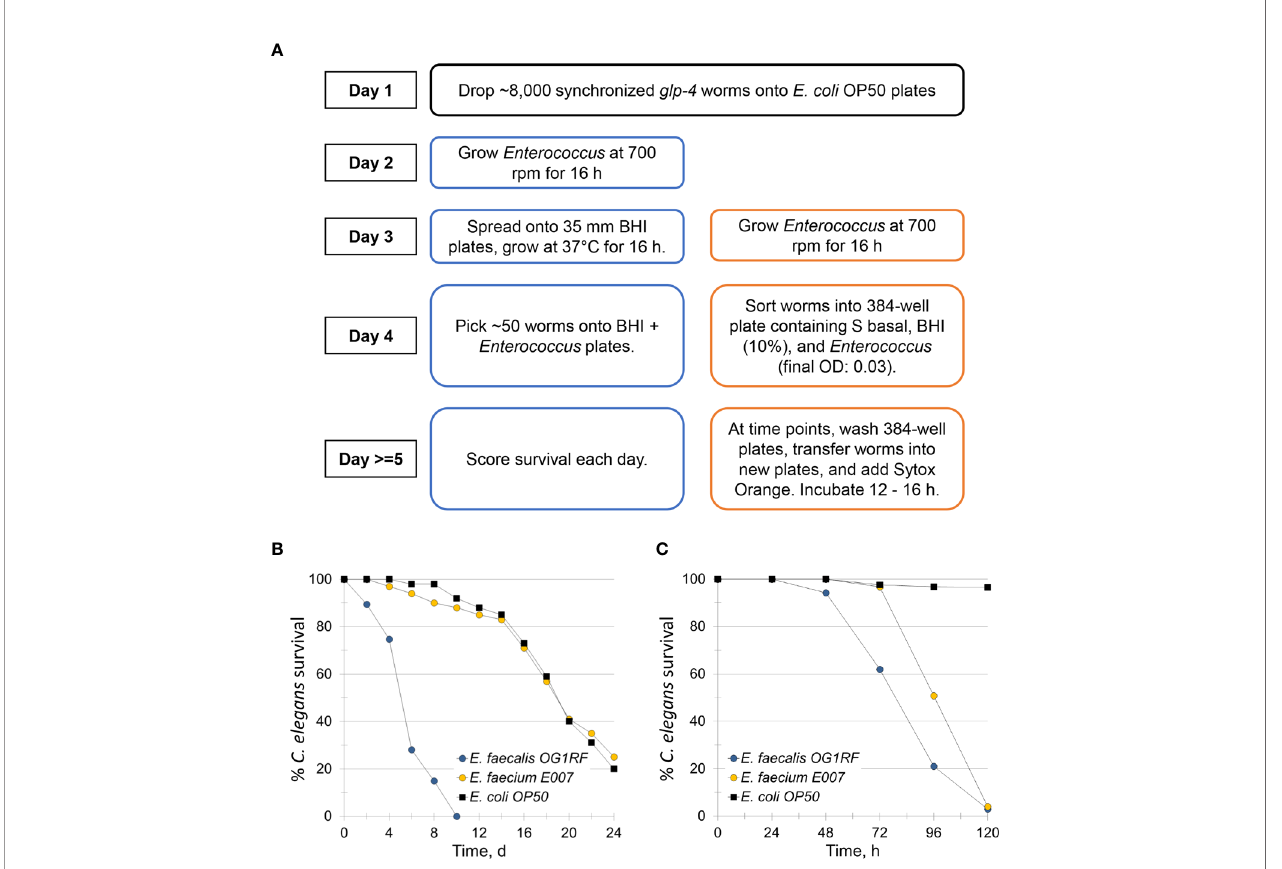
FIGURE 1 | E. faecium E007 is pathogenic to C. elegans in the Enterococcus liquid-killing assay. (A) High-throughput, liquid-based C. elegans – E. faecium killing assay pipeline (right, compared to the conventional agar-based assay (left)). (B, C) Survival curves of C. elegans that were exposed to E. faecalis OG1RF, E. faecium E007, or non-pathogenic E. coli OP50 either in the (B) agar-based assay or (C) under liquid conditions. Three biological replicates were performed and analyzed; representative replicates are shown for (B, C) .